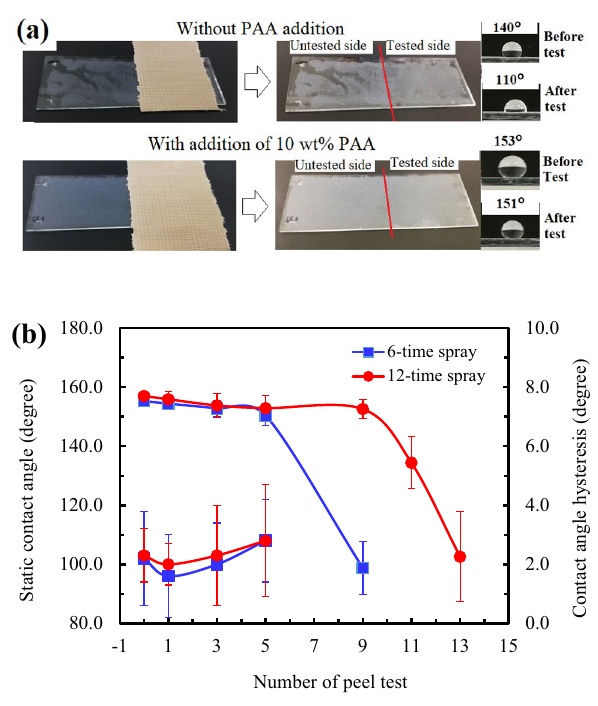
Fig. 6 Evaluation results of mechanical robustness of the coatings deposited on the glass slides by the one-step spray coating using the adhesive tape method. a Optical photographs of the coatings sprayed from the coating solutions without (Composition No. 3) and with the addition of 10 wt% PAA (Composition No. 5) by the processing method III before and after peel test. Insets in ( a ): Opti- cal photographs of a 10μL-water droplet and SCAs. b SCAs and CAHs of water on the superhydrophobic coatings sprayed with dif- ferent times on the glass slides using the coating solution with the addition of 10 wt% PAA after different numbers of peel test